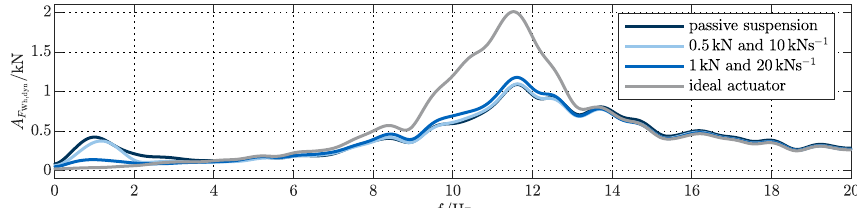
Figure A10. FFT of body acceleration for the BC profile at 90kmh − 1 .